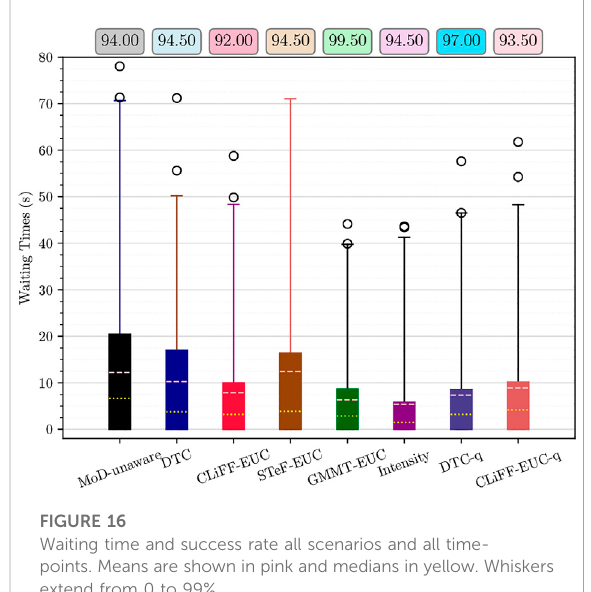
FIGURE 16 Waiting time and success rate all scenarios and all time- points. Means are shown in pink and medians in yellow. Whiskers extend from 0 to